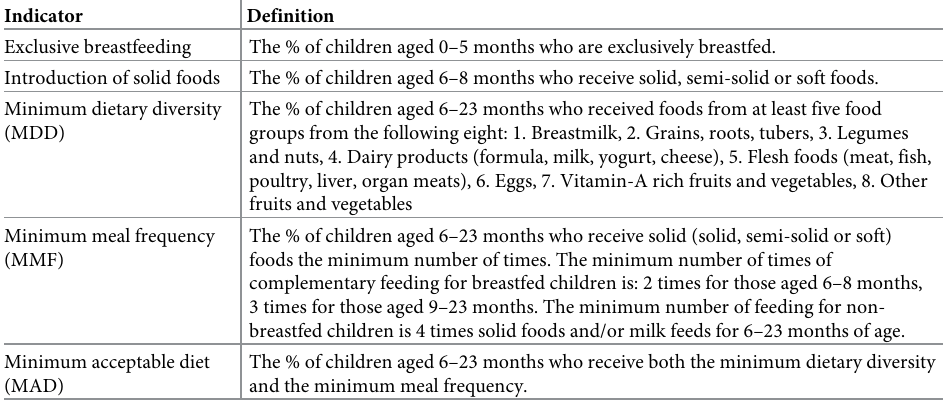
Table 1. Overview of key infant and young child feeding indicators and their definitions.